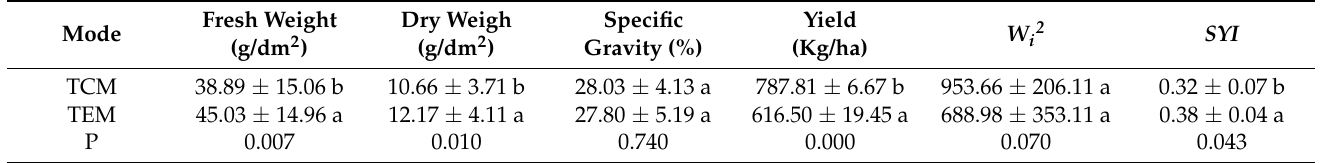
Table 3. The effects of management mode on the tea production indices.